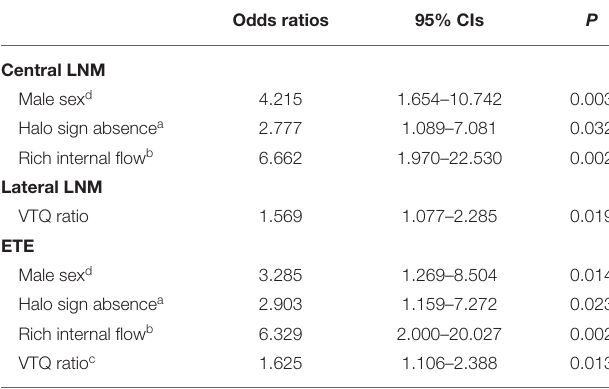
TABLE 4 | Multivariate logistic regression analysis in predicting